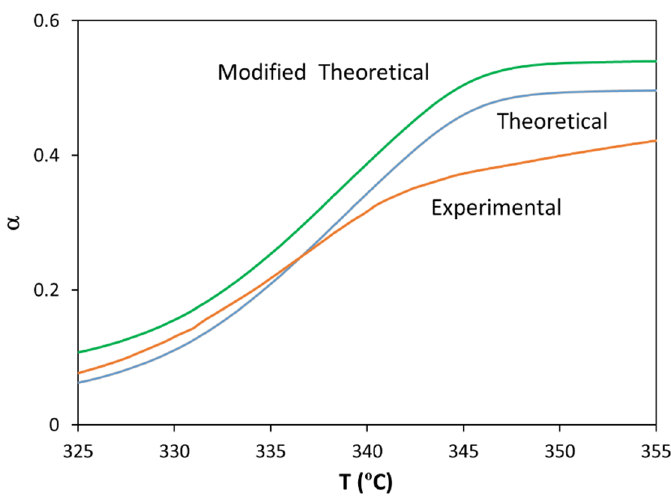
Figure 3. Variation in conversion with temperature for the bioblend containing 50% PLA (nominal heating rate = 10 K/min).